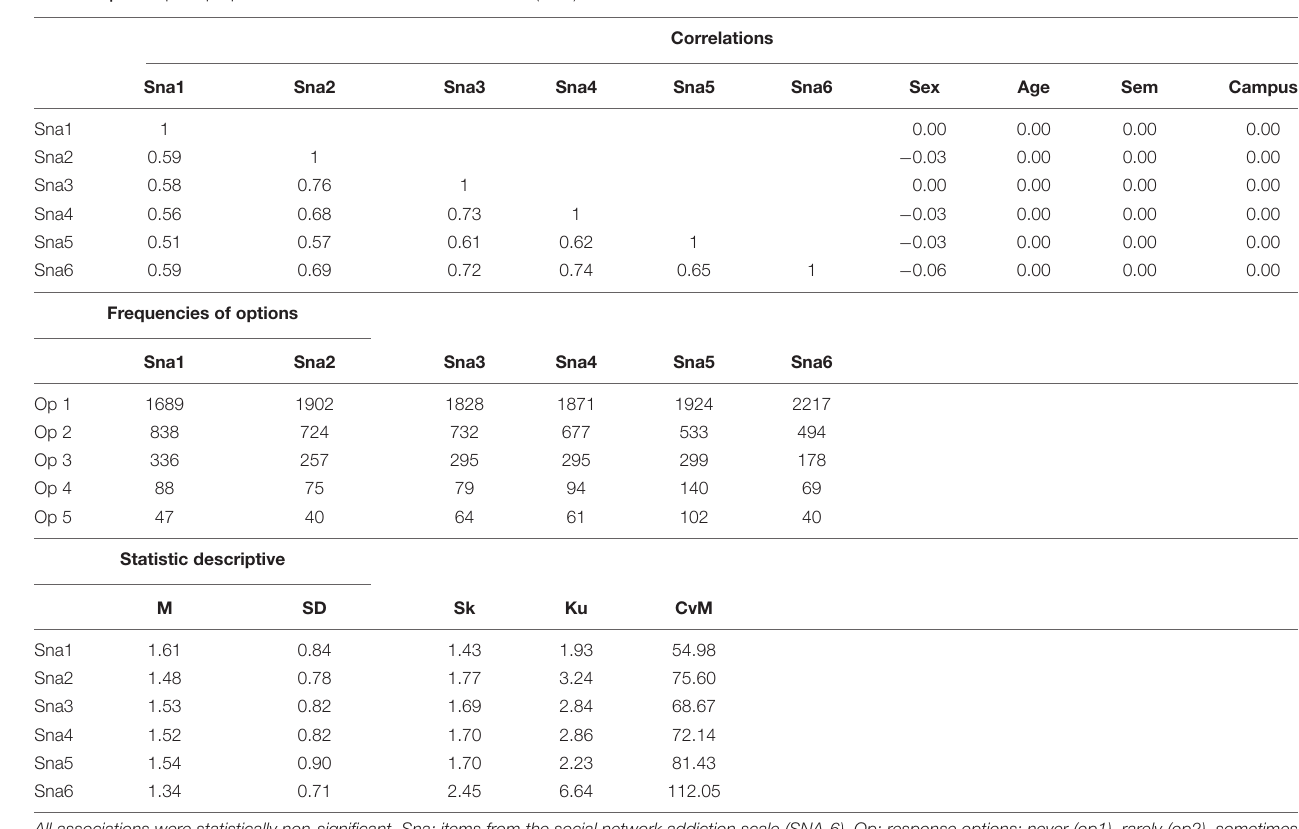
TABLE 2 | Descriptive properties for the social networks addiction (SNA)-6 items.